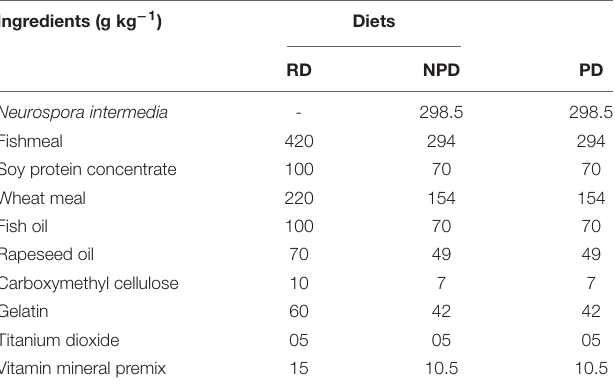
TABLE 1 | Dietary composition (g kg − 1 on dry matter basis) of the reference diet (RD), non-preconditioned diet (NPD), and preconditioned (heat-processed) diet (PD).